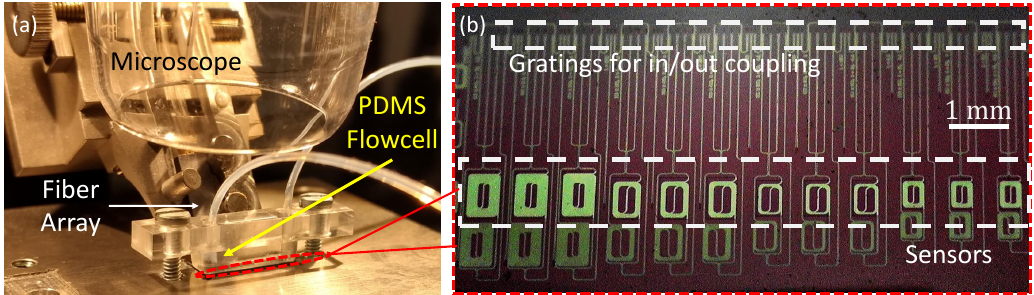
Figure 3. ( a ) Part of the experimental setup showing the fiber array for light coupling and the flowcell covering the photonic sensing chip. ( b ) Sensing chip highlighting the coupling zone for the fiber array and the sensor region.